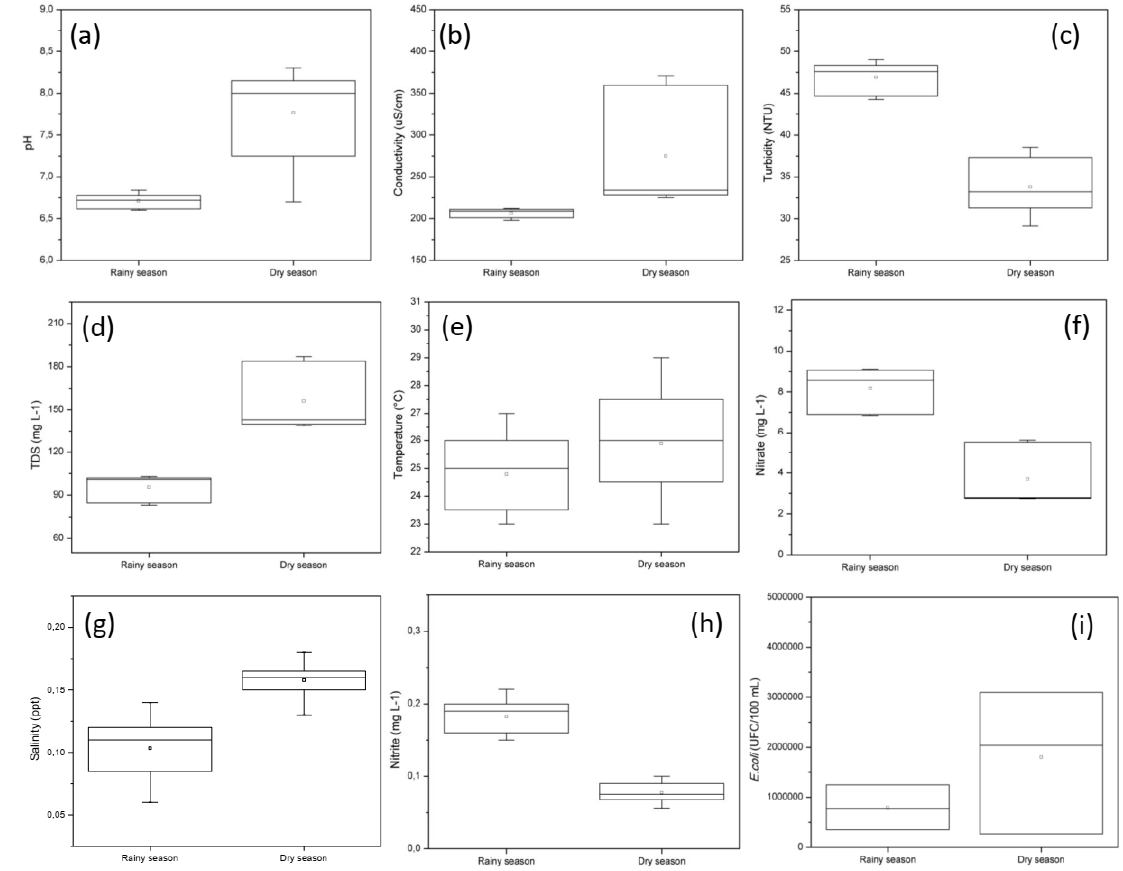
Figure 3. Box plots ( a ) pH, ( b ) conductivity, ( c ) turbidity, ( d ) TDS, ( e ) temperature, ( f ) nitrate, ( g ) salinity, ( h ) nitrite and ( i ) E. coli for different seasons.